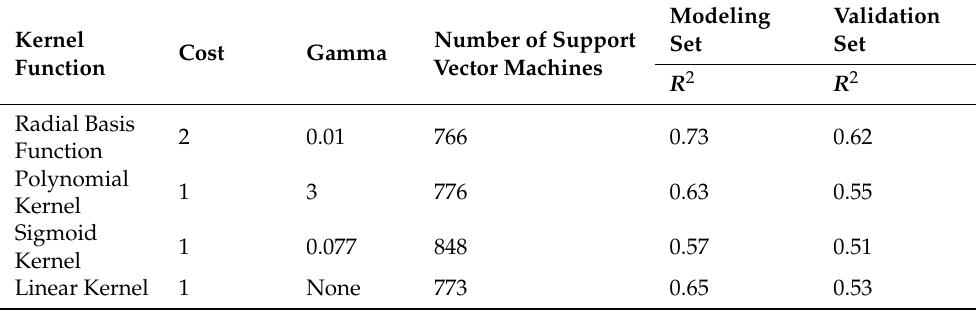
Table 5. Comparison of the test results of different kernel functions of the SVR